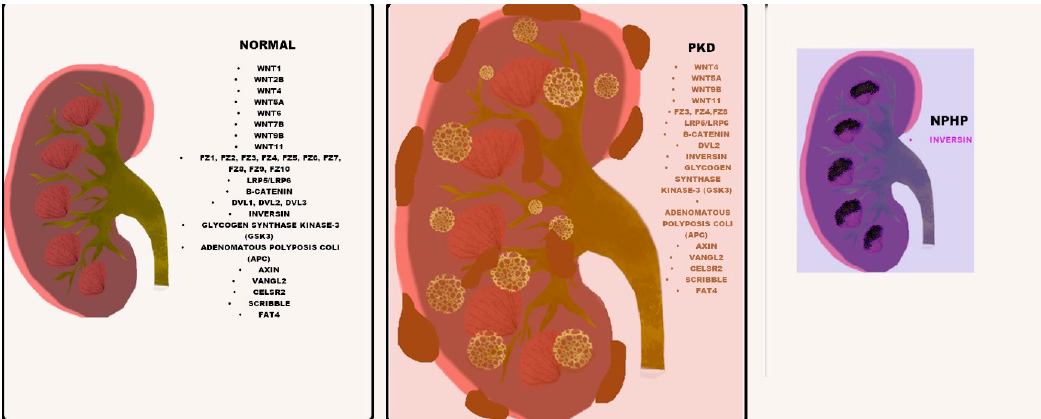
Figure 1. Wnt component expression in normal, PKD and NPHP kidneys. The listed Wnt components (black) are expressed in all three normal, PKD and NPHP kidneys, with differential expression in PKD indicated in orange and differential expression in NPHP shown in purple. High-resolution figure has been provided.